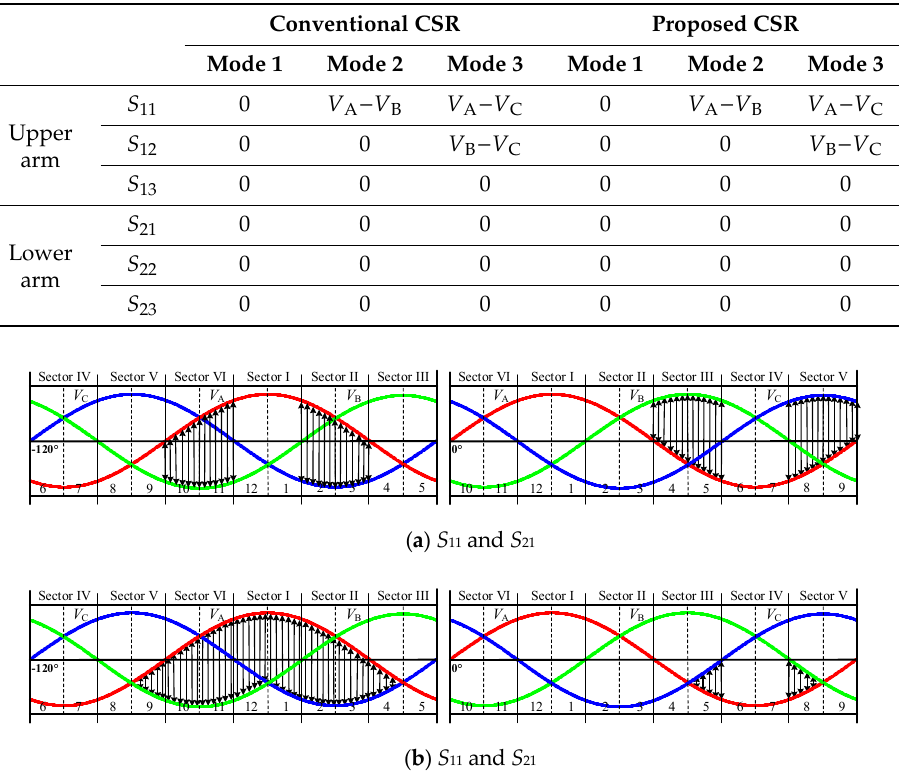
Figure7. Comparativeschematicdiagramofthevoltagestress. ( a )ConventionalCSR.( b Figure 7. Comparative schematic diagram of the voltage stress. ( a ) Conventional CSR. ( b ) Proposed CSR.